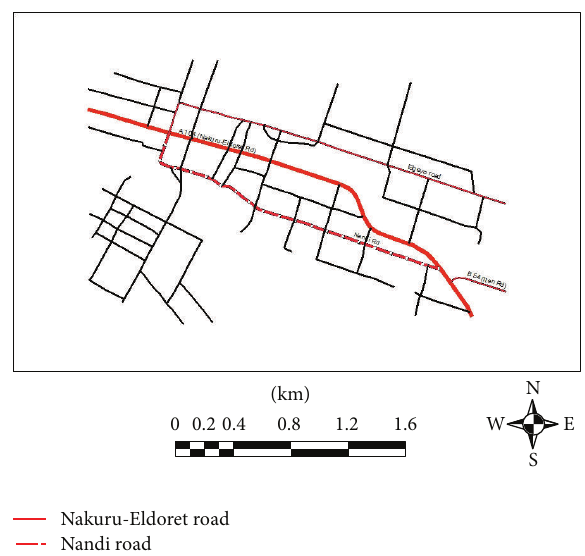
Location of Nandi road in Eldoret Town